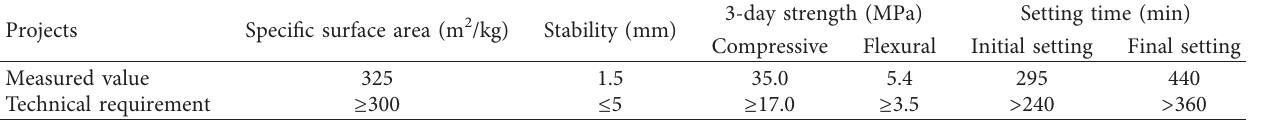
Table 1: Technical indicators of cement.